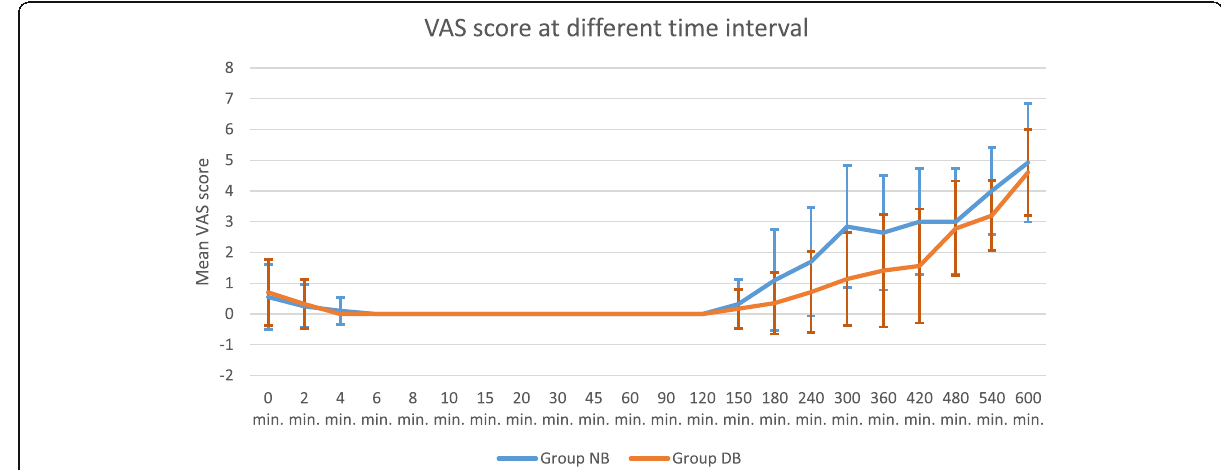
Fig. 3 Visual analogue score for pain at different time